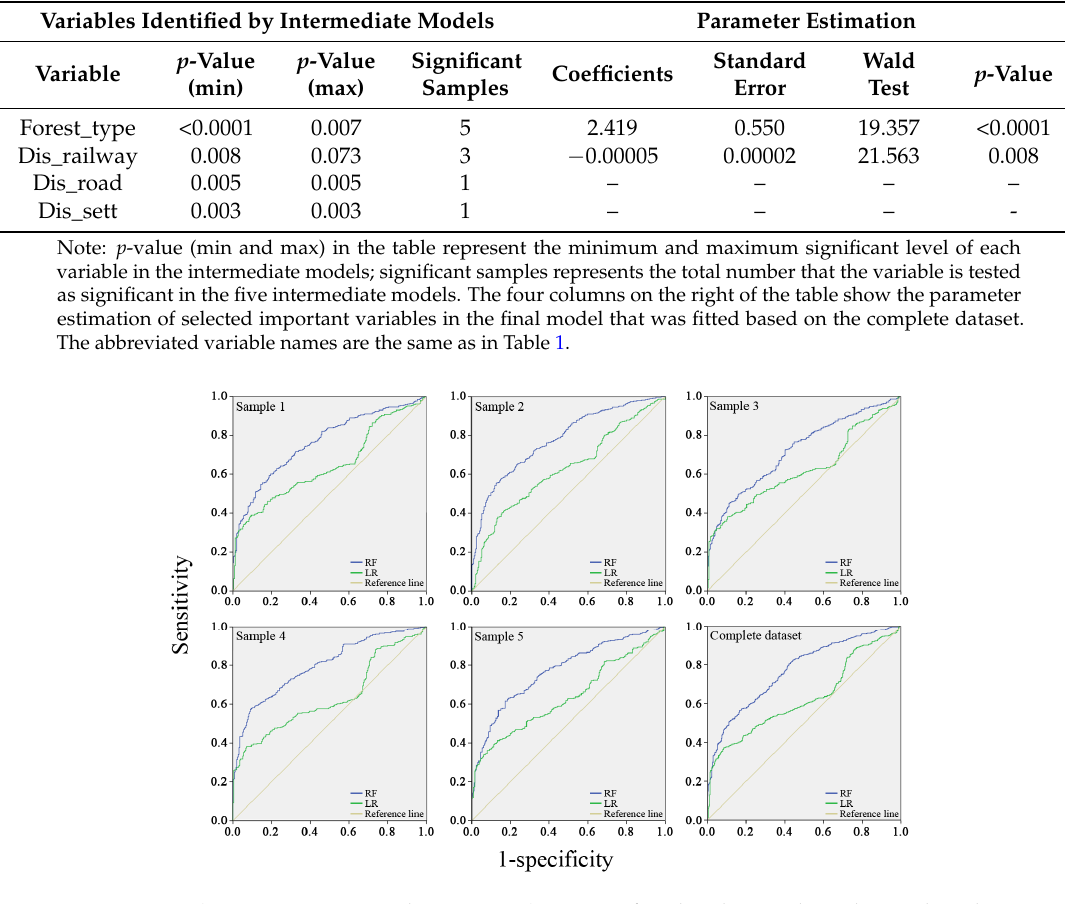
Figure 5. ROC (receiver operating characteristic) curves of each sub-sample and complete dataset using Random Forests (RF) and logistic regression (LR) models. The upper curve has a bigger area under curve (AUC) meaning higher predictive ability.